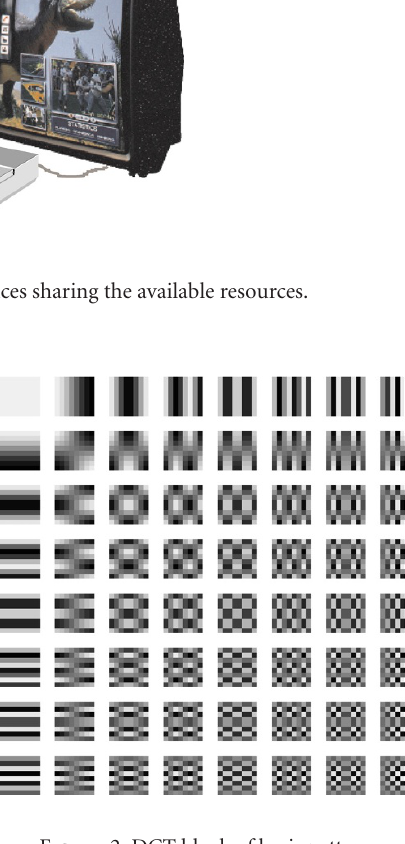
Figure 2: DCT block of basis